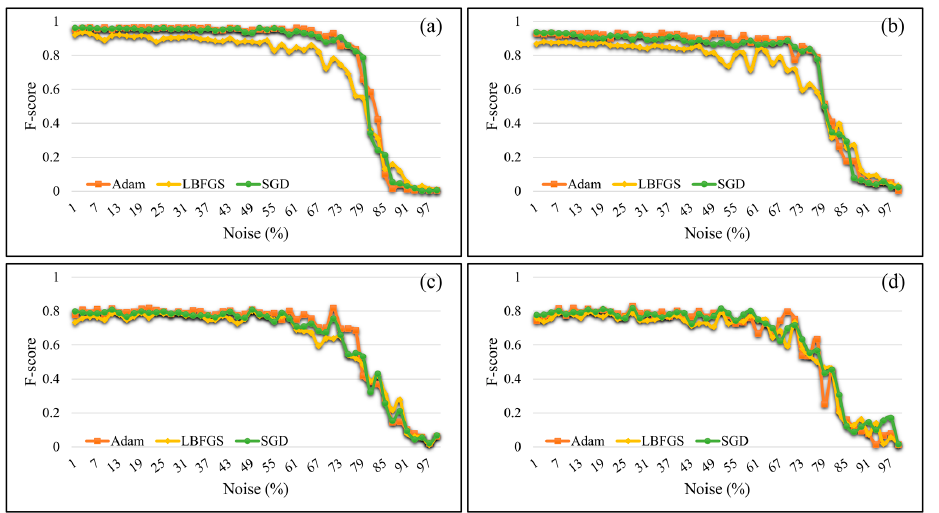
Figure 11. The obtained F ‐ score values for the ANN models using ( a ) all (16,000), ( b ) 5000, ( c ) 1000, and ( d ) 500 training samples with noise labels (i.e., wrong labels). and ( d ) 500 training samples with noise labels (i.e., wrong